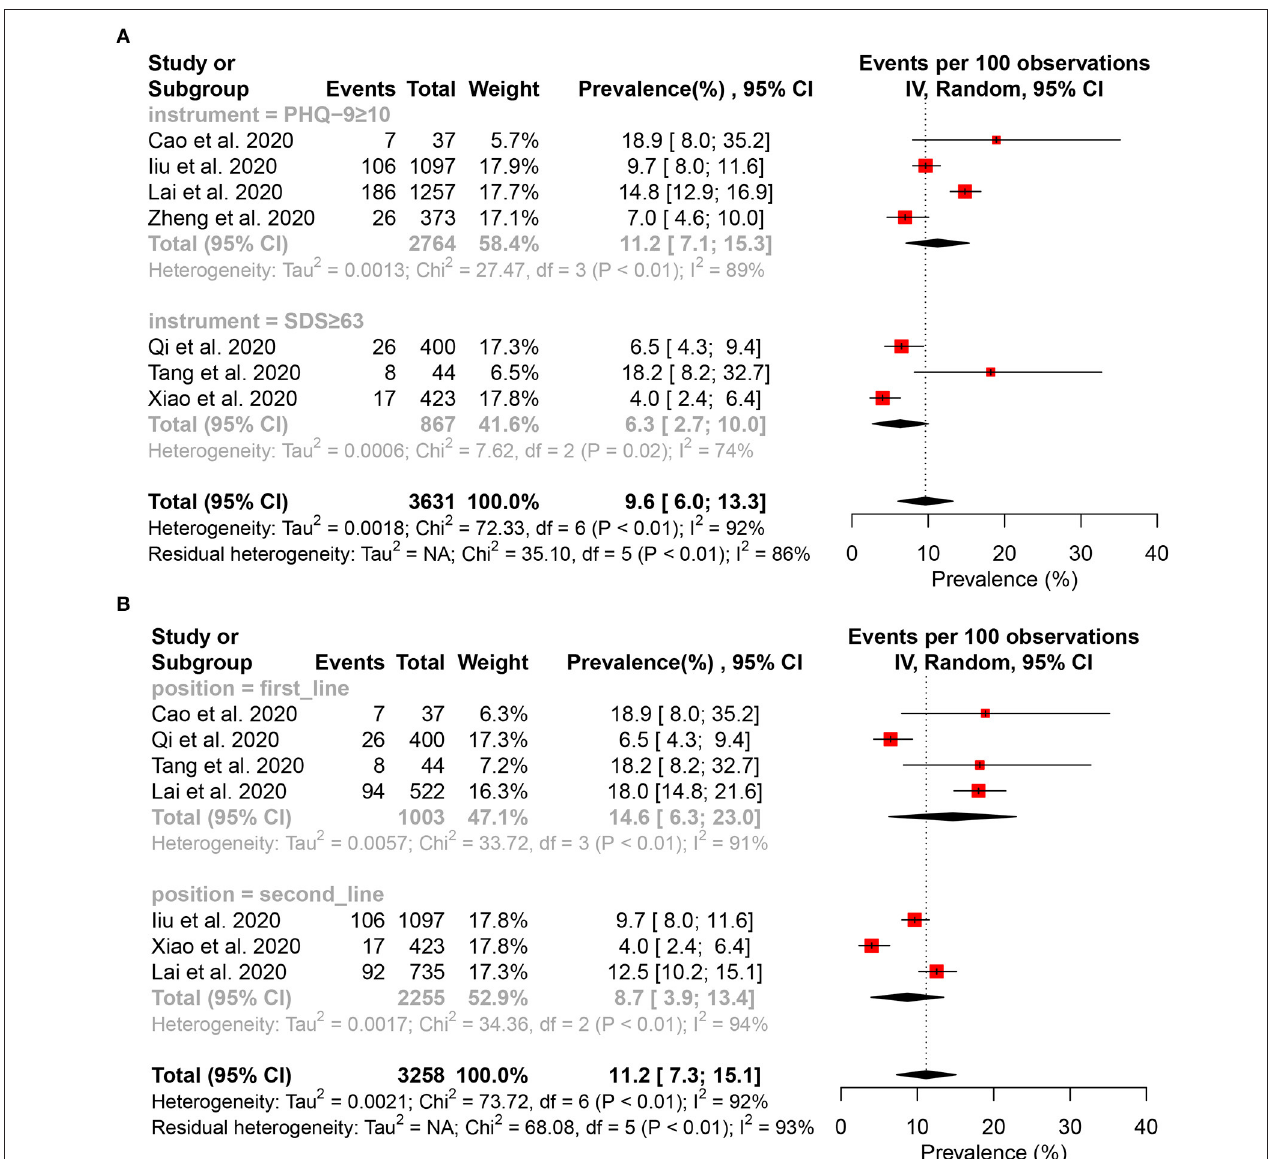
FIGURE 4 | Forest plot for the meta-analysis of the prevalence of moderate to severe depression and subgroup analysis among healthcare workers. (A) Forest plot of the prevalence of moderate to severe depression. (B) Forest plot of moderate to severe depression stratification by